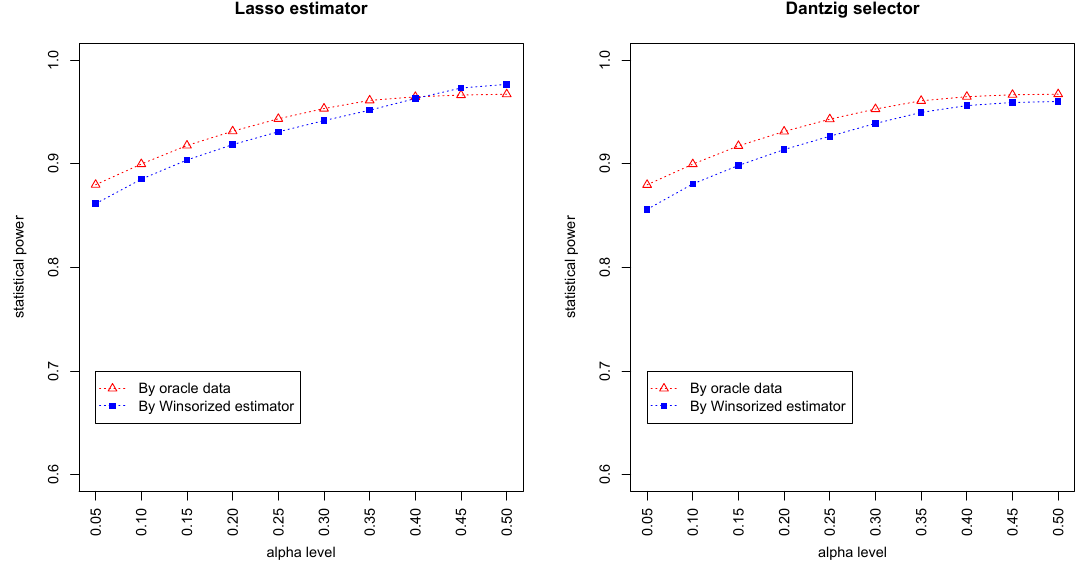
Figure 3. Statistical powers by oracle data and Winsorized imputations under the band graph setting. The x -axis represents the desired FDR levels from 0.05 to